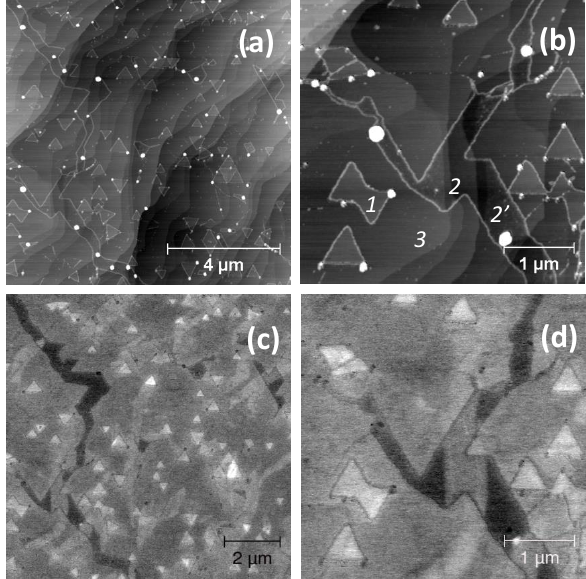
Figure 4. KPFM data obtained on the same sample of Figure 3: ( a , b ) topography at two different magnification and ( c , d ) the corresponding first harmonic channel maps, obtained applying 1 V to the tip, at a frequency of 489 kHz.